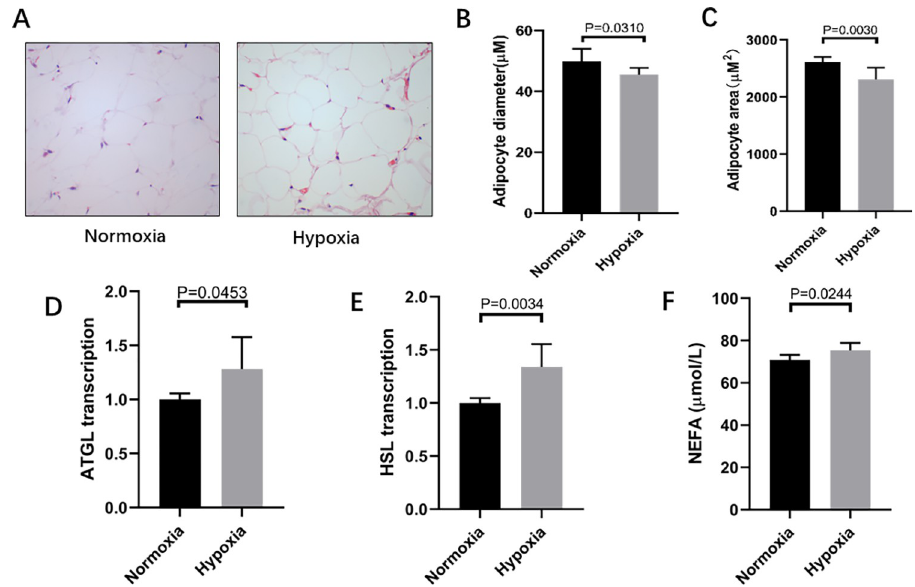
Fig 4. Effects of hypoxia on markers of lipolysis. Haematoxylin and eosin staining, scale bar:10 μ m, (B) adipocyte diameter, and (C) adipocyte area changes in the visceral adipose tissue in the hypoxia group versus the normoxia group. The mRNA levels of lipolysis related-genes,including (D) adipose TG lipase (ATGL), and (E) hormone- sensitive lipase (HSL). (F) The content of NEFA. A-C: n = 3 rats per group.D-E: n = 6 rats per group. Independent- samples t-test was used for statistical analysis.